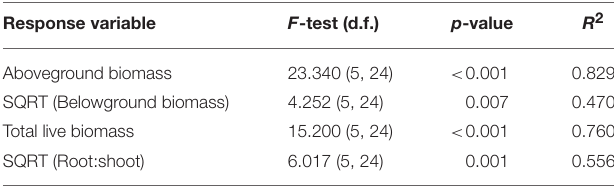
TABLE 3 | Results of general linear model fit tests for the response variables aboveground, belowground, and total live biomass, as well as root:shoot ratio.